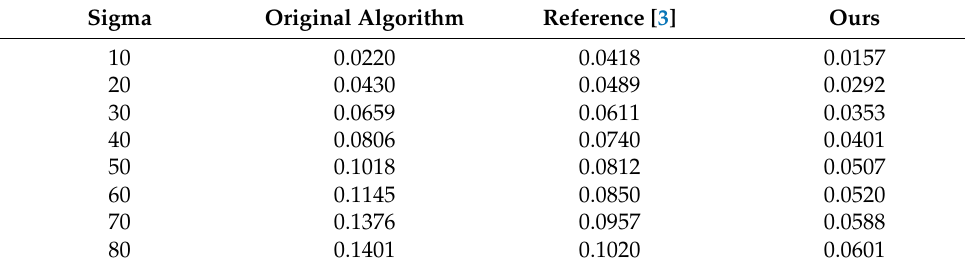
Table 4. MSE of the three algorithms for the Monarch image.